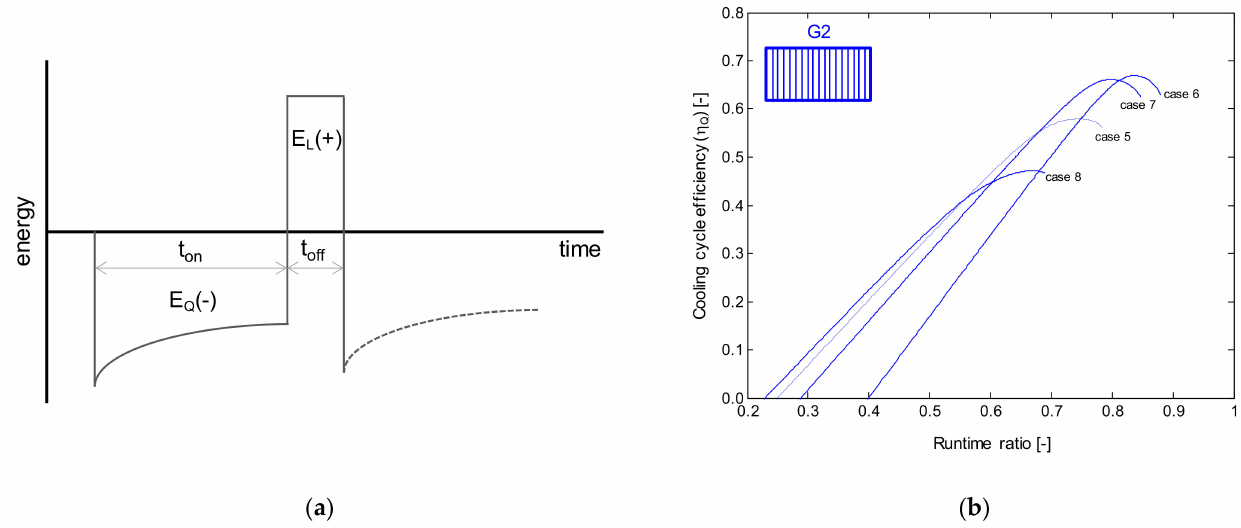
Figure 14. Representation of the cooling and defrost cycles ( a ), and the so-called cooling cycle efficiency as a function of the compressor runtime ratio ( b )